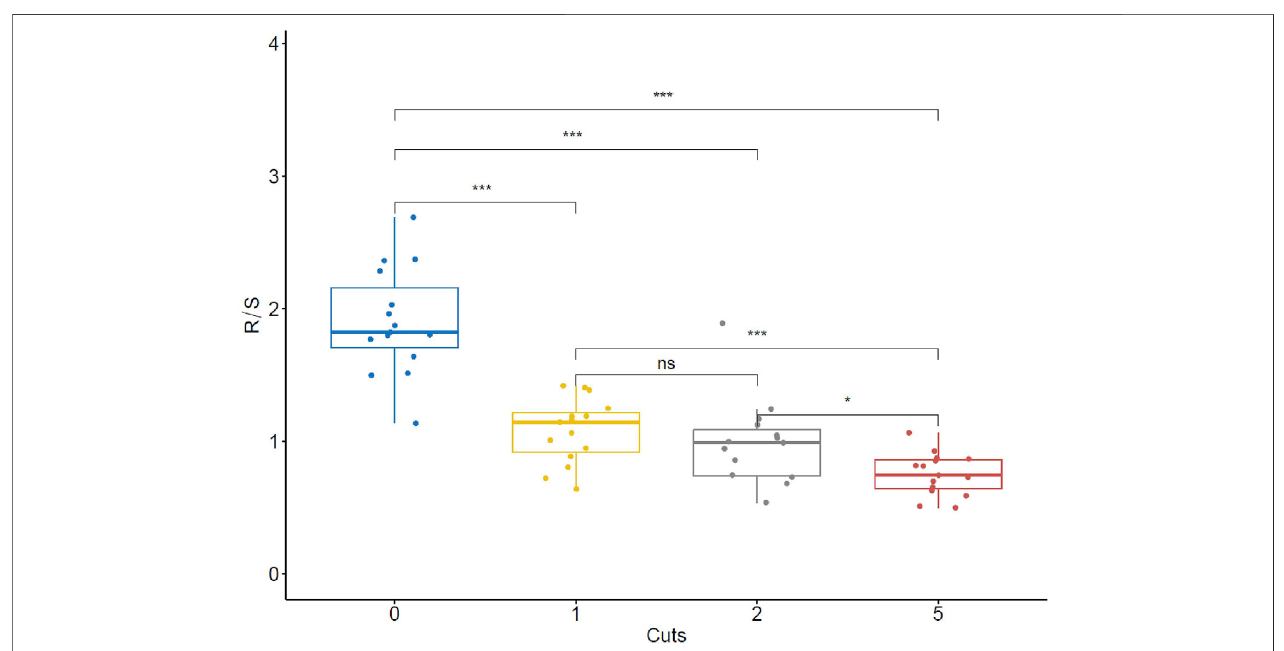
FIGURE 3 | Differences of root:shoot ratios (R/S) for the various treatments of zero, one, two, and fi ve annual cuts across species. Stars denote statistical signi fi cances between treatments according to p -values with ns indicating non-signi fi cance.